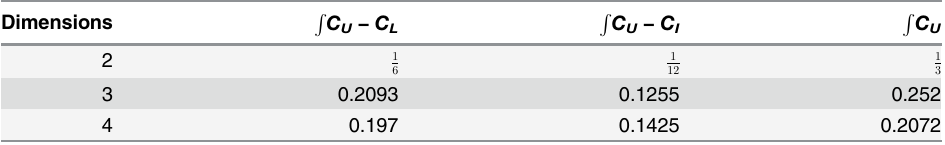
Table 1. Integral of Copula Differences for different